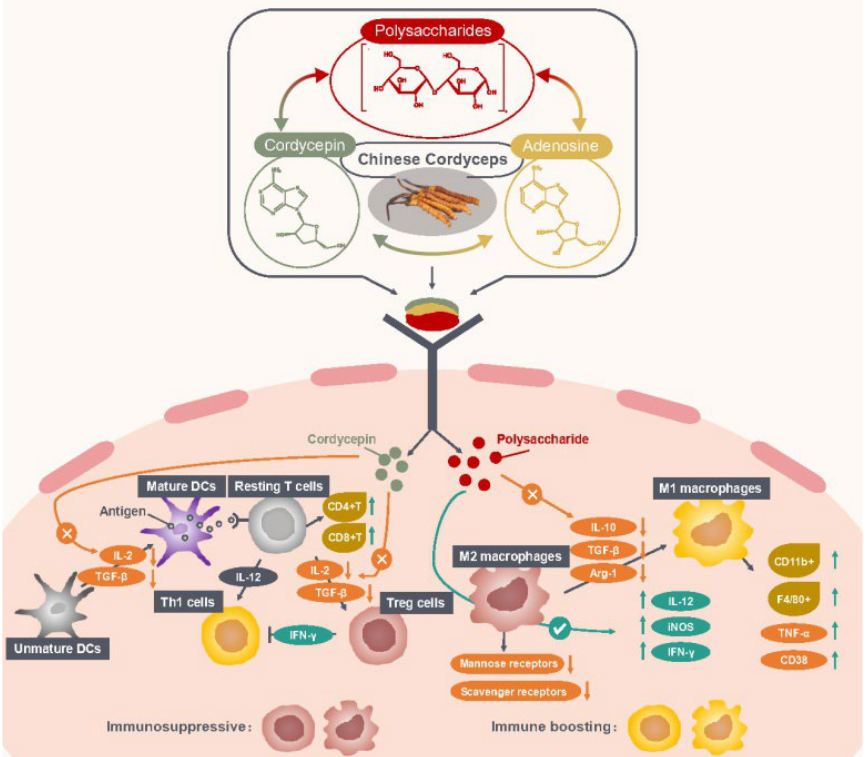
Figure 2. Mechanism of Chinese Cordyceps regulating immune cells in TIM. Abbreviations: Arg-1, arginase-1; CD38, CD11b + and F4/80 + , M1 macrophage markers; IFN- γ , interferon-gamma; IL, interleukin; iNOS, inducible nitric oxide synthase; TGF- β , transforming growth factor-beta; TIM, tumor immune microenvironment; TNF- α, tumor necrosis factor -alpha.